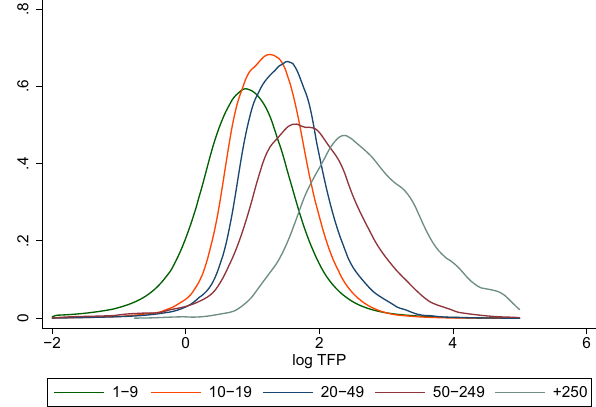
Fig.1 DistributionofproductivitybysizeclassinSpain. Notes ThisfigureplotsthedistributionoflogTFP of Spanish firms over the period 2000–2007 by size class. The five size categories reported are: (1) from 1 to 9 employees; (2) from 10 to 19 employees; (3) from 20 to 49 employees; (4) from 50 to 249 employees; (5) more than 250 employees. The distribution is estimated by means of an epanechnikov kernel function using the optimal bandwidth that minimizes the mean integrated squared error